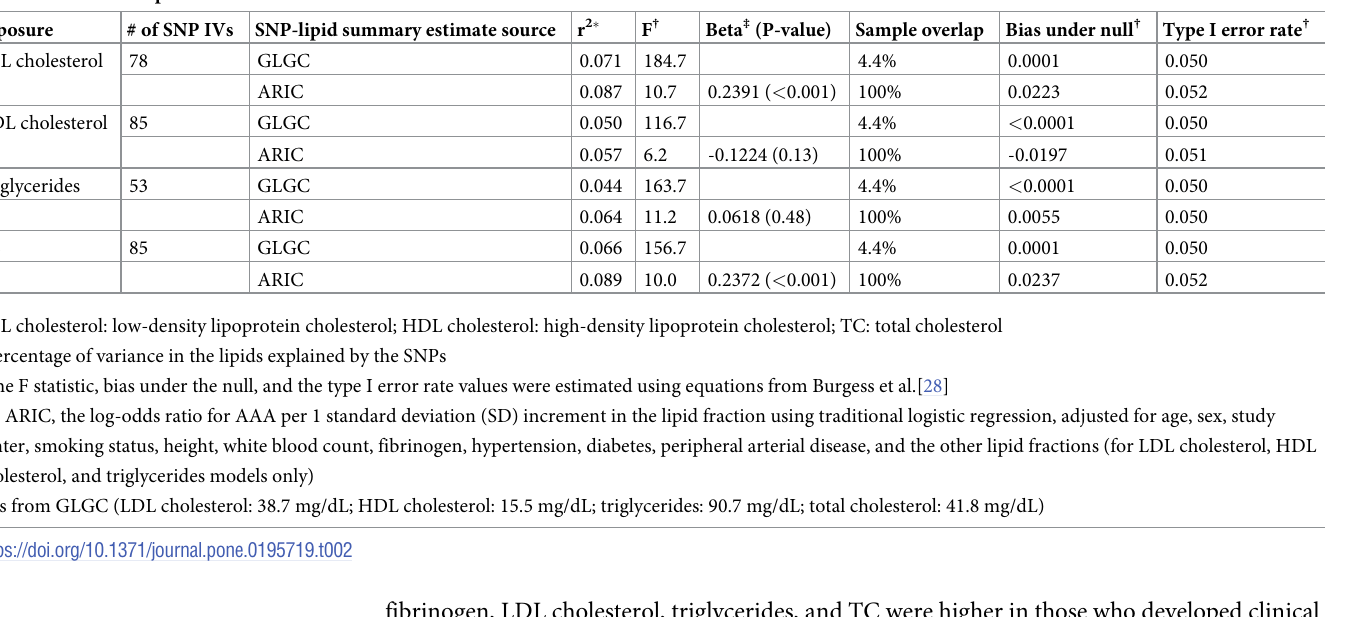
Table 2. Estimated strength of SNP IVs and susceptibility to weak instrument bias using the two-sample Mendelian randomization approach for estimating the association between lipids and AAA risk. Exposure